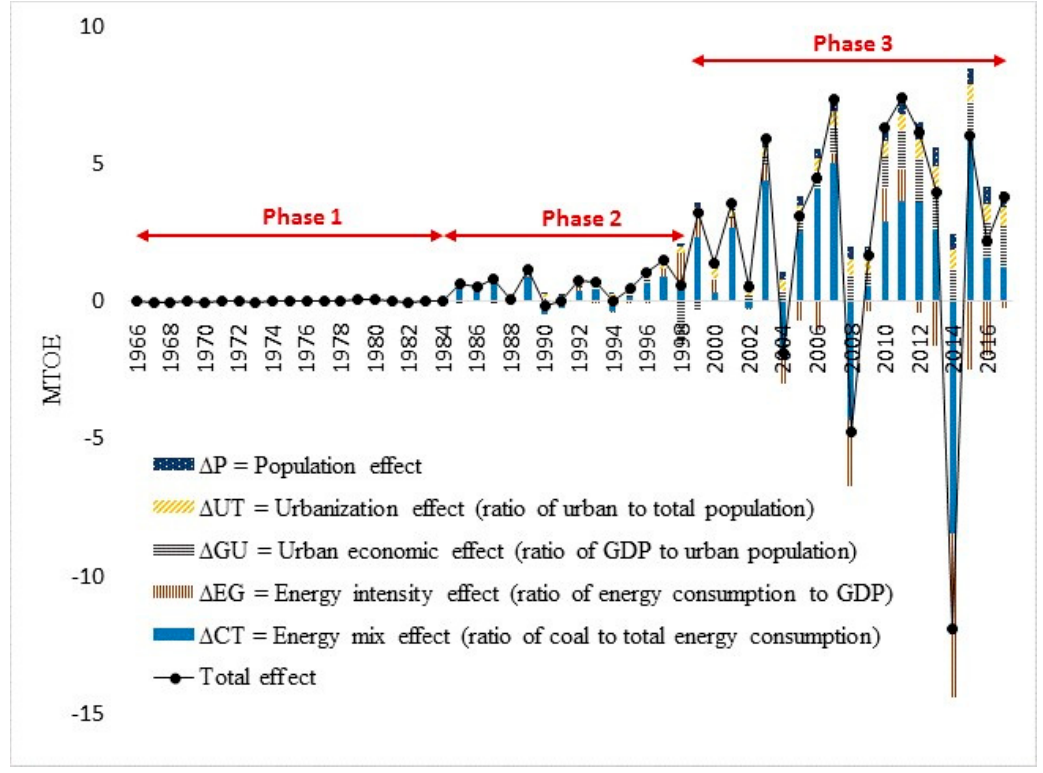
Figure 7. Decomposition of annual coal consumption growth.